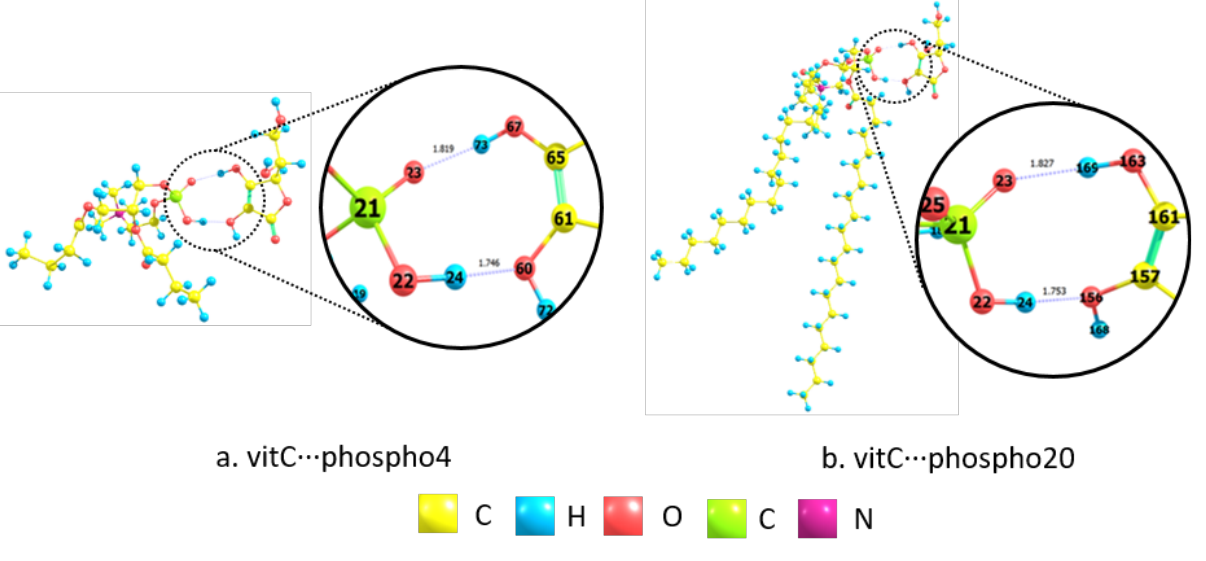
Figure 3 : Intermolecular interaction between vitamin C and phospholipid molecules.